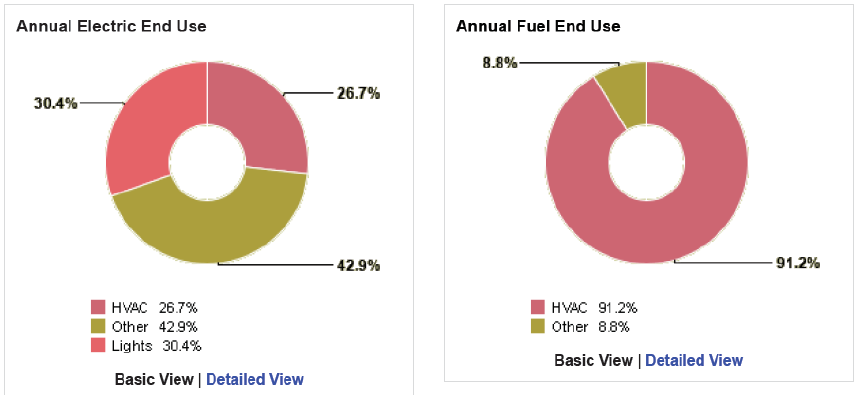
Figure 24. Annual costs of Double skin facade (Green Building Studio).